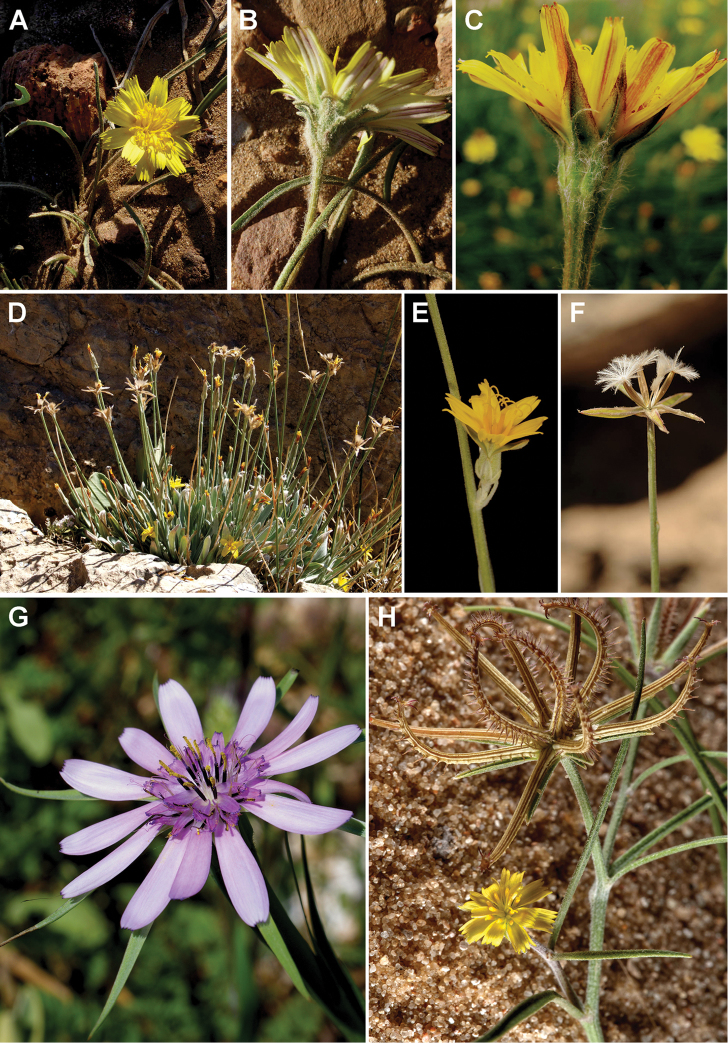
Images of living plants. A, B – Tourneuxia
variifolia (Morocco, near Mrhimina). Photographs by A. Garcin (www.teline.fr) C – Gelasia
villosa (cult. in BG Berlin, 13 Jun 2010). Photograph by N. Kilian D, E, F – Gelasia
rigida (Jordan, Nakeb, 1250 m alt., 8 May 2019). Photograph by O. Fragman-Sapir. D general view E capitula in flowering F capitula in fruiting, a part of achenes had fallen off GGeropogon
hybridus (Greece, Lefkas, 15 May 2016). Photograph by E. Willing HKoelpinia
linearis (Qatar, Khashem Al Nekhsh area, 18 Mar 2016). Photograph by A. Sergeev.